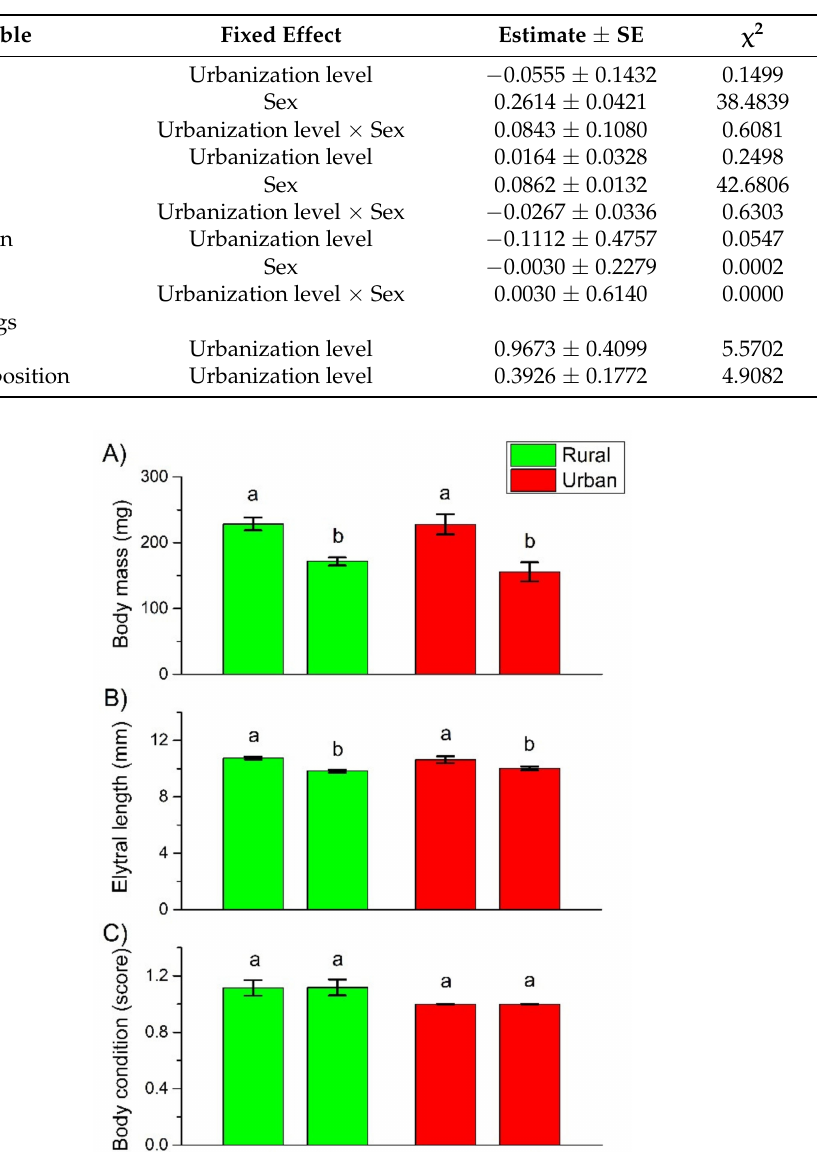
Table 1. Summary of GLMM results and post hoc tests on life-history traits of Carabus convexus in differently urbanized (non-urbanized vs. urbanized) forested habitats ( p -values in bold denote significant effects).